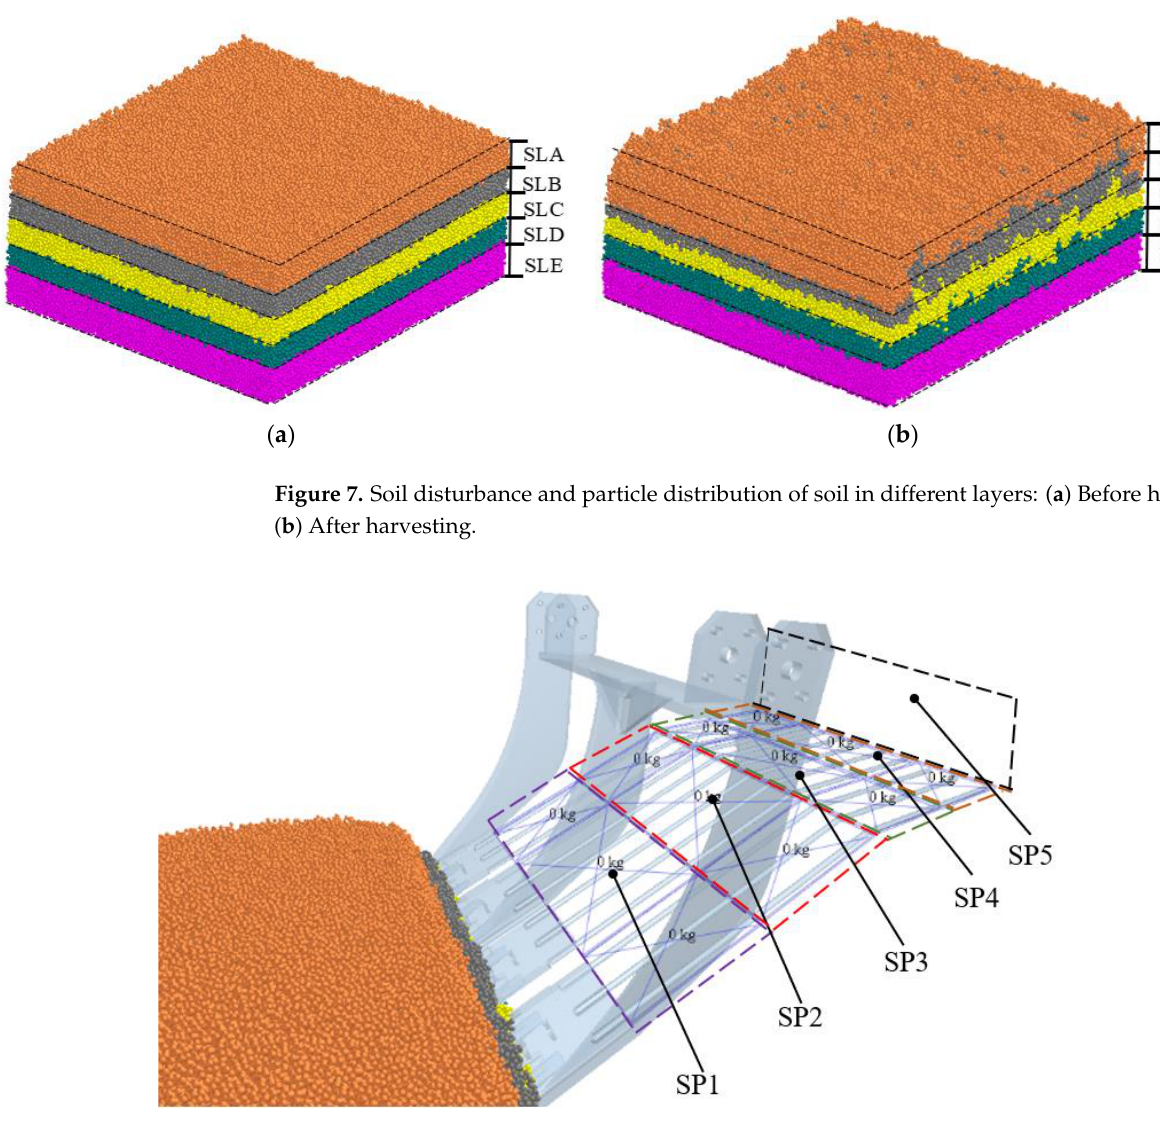
Figure 7. Soil disturbance and particle distribution of soil in different layers: ( a ) Before harvesting; ( b ) After harvesting.